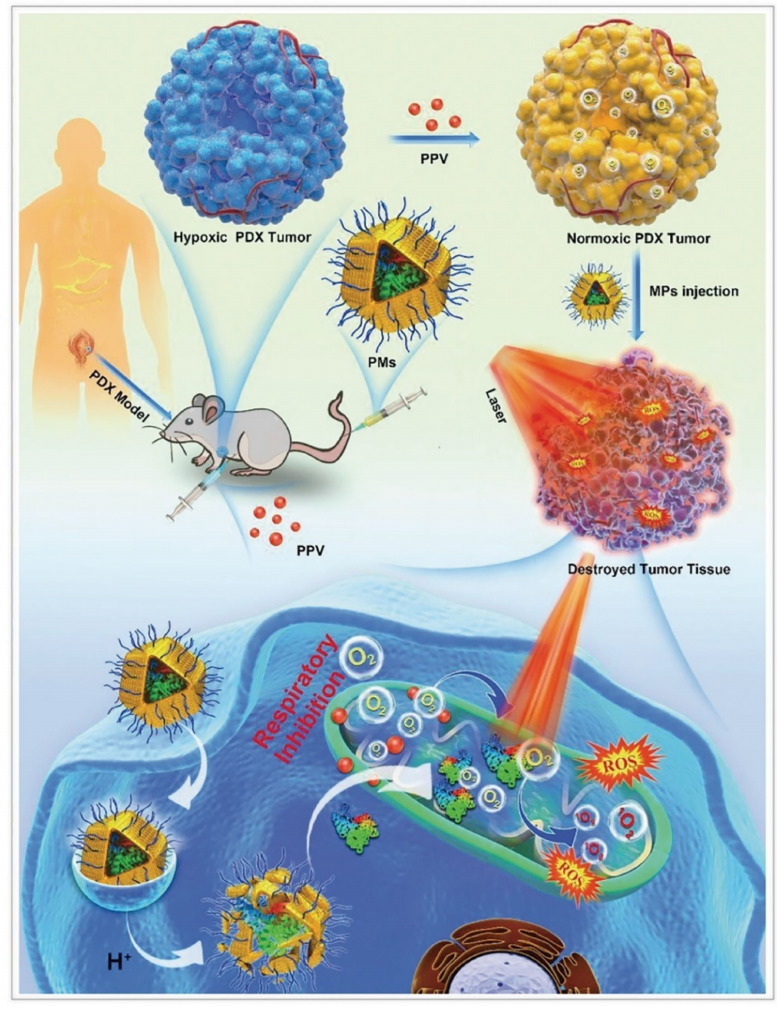
Figure 4. ZIF–8 nanoplatforms for individual photo therapy. Antitumor mechanism of MPEG2000– ZIF/phycocyanin composites (PMs) in the patient–derived xenograft models. Reprinted with permis- sion from ref [66]. Copyright 2020 Wiley–VCH